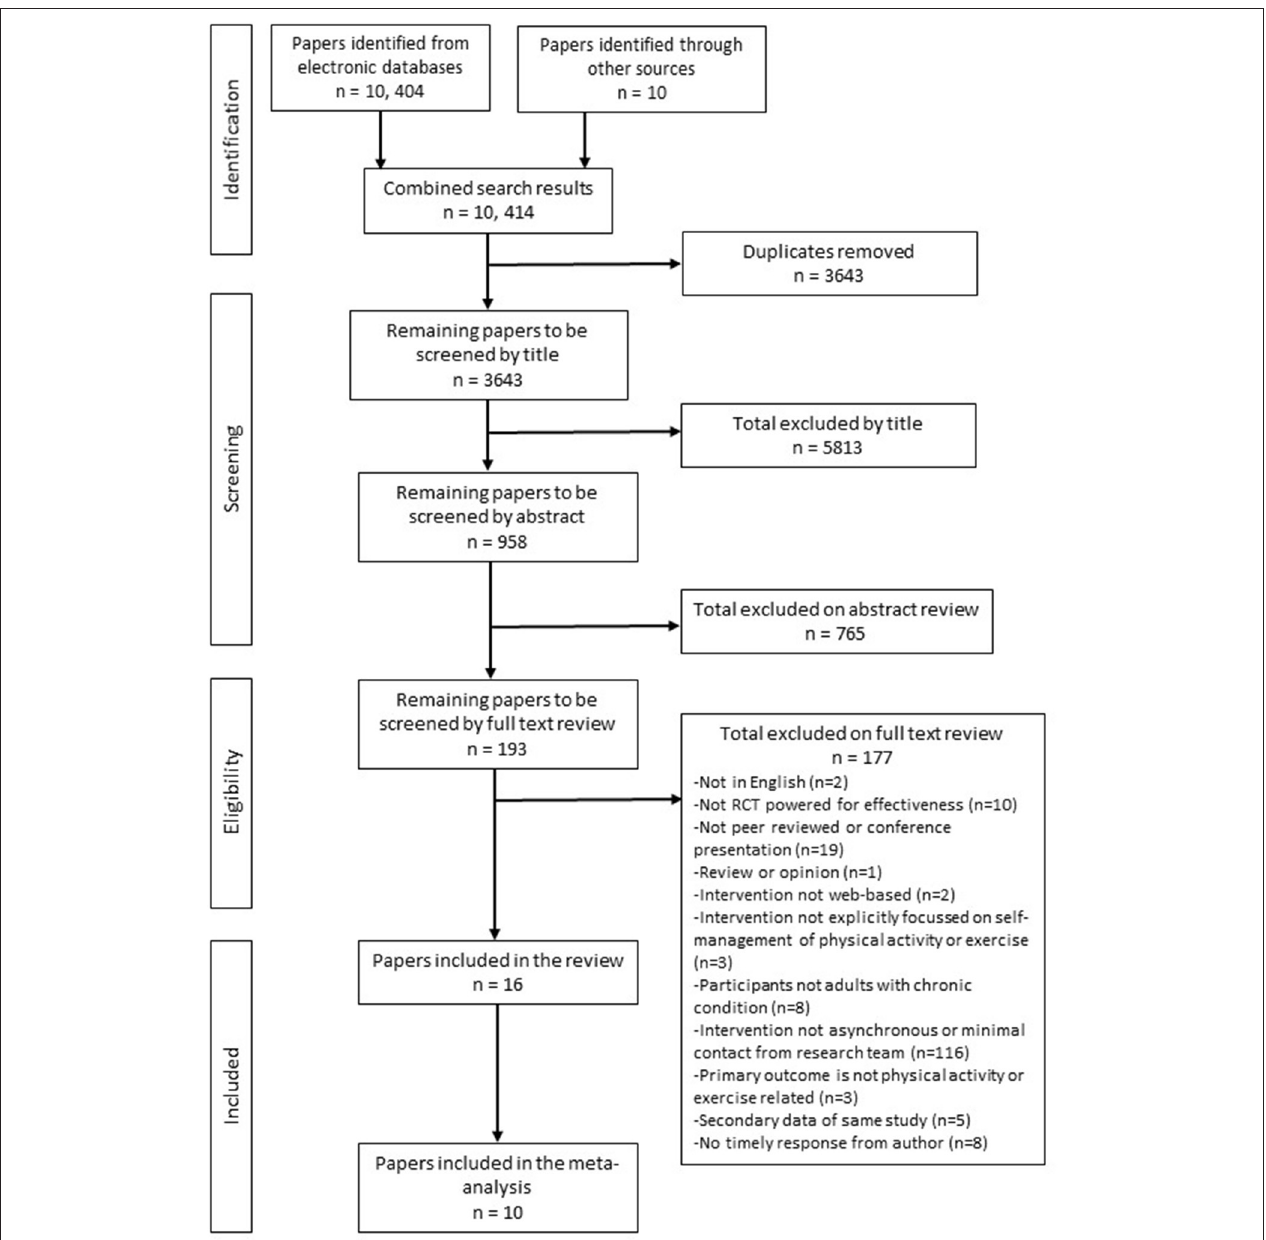
FIGURE 1 | Flow chart summarizing the study selection